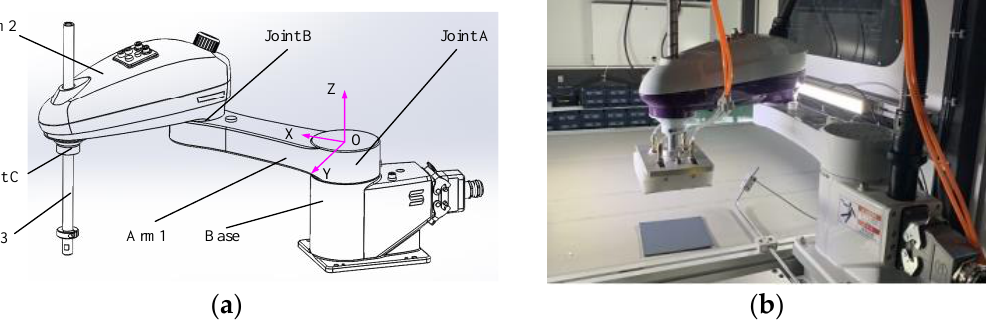
Figure 7. Assembly robot and working status. ( a ) The structure model of the robot; ( b ) the actual picture of the robot on the production line.